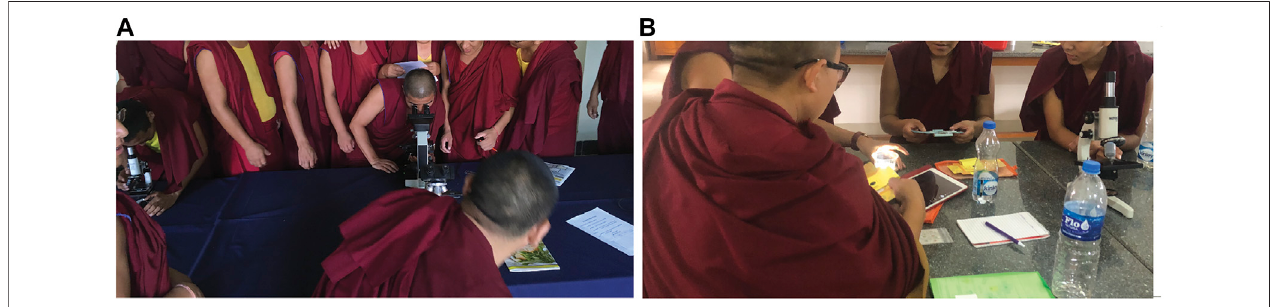
FIGURE 1 | Morning class and afternoon labs, Drepung Monastery. (A) Science monks running the show during the afternoon lab microscope demonstration. (B) Using Foldscopes and posting